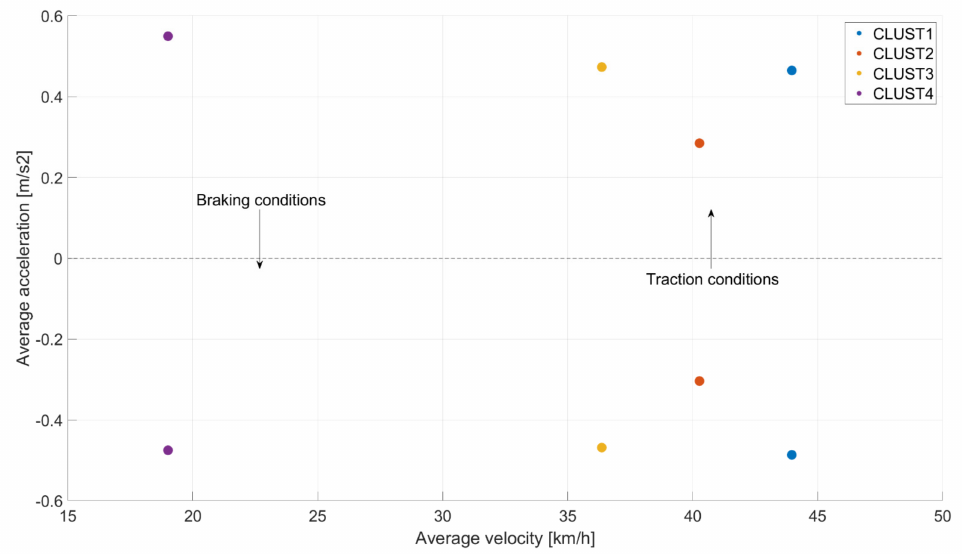
Figure 7. Comparison of the average accelerations realized in CLUST1, CLUST2, CLUST3 and